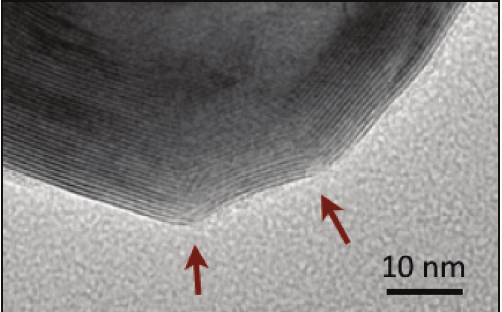
Figure 6. Cracks in the vertices of the particles are the only evidence of damage in samples subjected to shock tube tests. No crack propagation or structure collapse was observed. No evidence of delamination was found